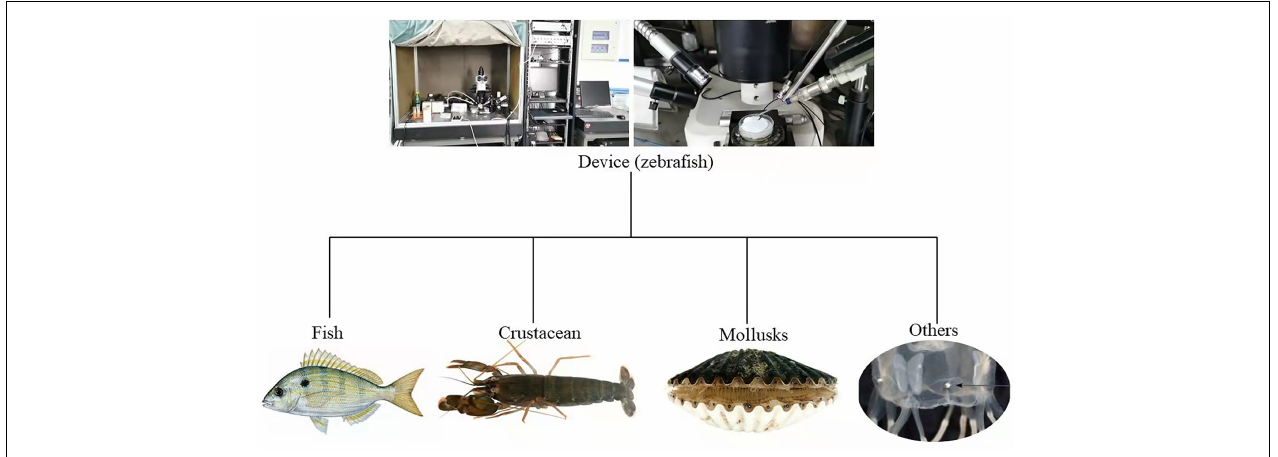
FIGURE 2 | Part of the device diagram for electroretinogram testing of aquatic animals discussed in this review (Coates et al., 2006; Mccomb et al., 2013; Kingston et al., 2017, 2019; Liu et al.,